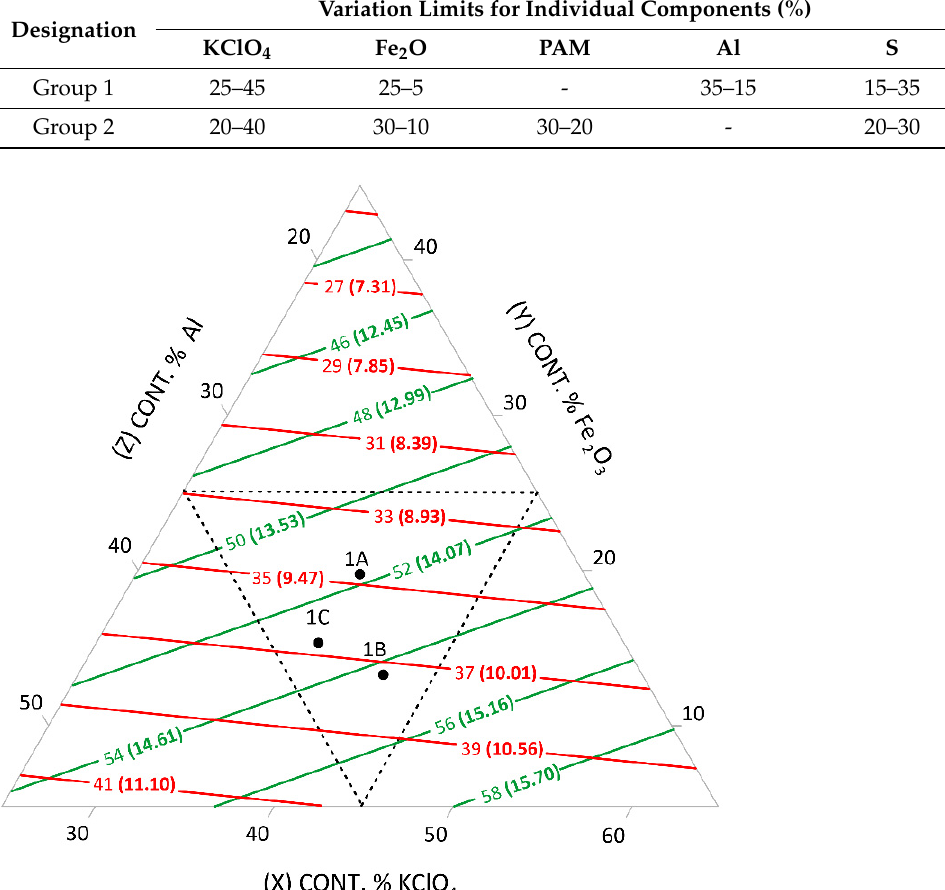
Figure 1. Relationship between costs of the composition (USD/kg): red line—1981, green line—2021; and the content of pyrotechnic composition components (%). Sides of the triangle, with fixed sulphur content S = 15%.